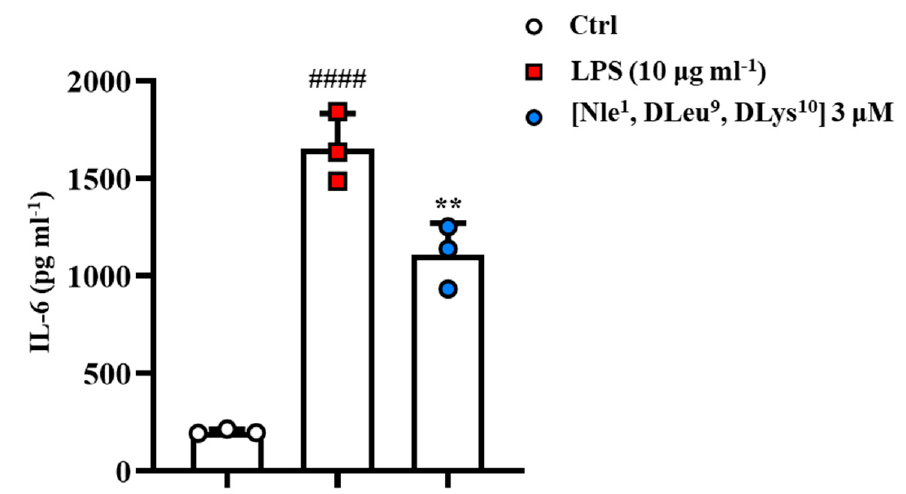
Figure 6. J774A.1 murine macrophage cells were stimulated with LPS (10 µ g mL − 1 ) and treated with [Nle 1 , D Leu 9 , D Lys 10 ] at the concentration of 3 µ M for 24 h. Thereafter, cell supernatants were assayed for IL-6 enzyme linked immunosorbent assay as pg mL − 1 and presented as means ± S.D. of three independent experiments. #### p ≤ 0.0001 vs. Ctrl group; ** p ≤ 0.01 vs. LPS group. Statistical analysis was performed by one-way ANOVA followed by Bonferroni’s for multiple